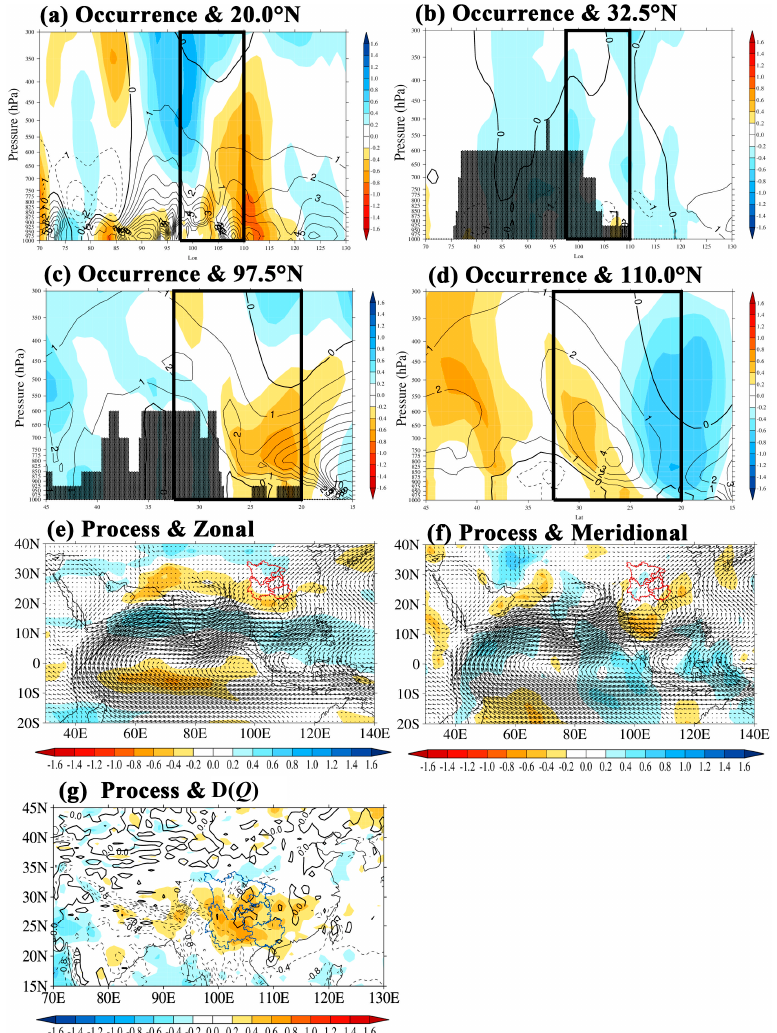
Figure 14. ( a – d ) Same as Figure 6a–d, respectively, which represent vertical cross-sections of composited meridional or zonal water vapor transport (WVT) for drought occurrences at the boundaries of Southwest China (SWC). ( e , f ) Same as Figure 5a,e, which are composites of: ( e ) zonal; and ( f ) meridional standardized anomalies (SA) of vertically integrated water vapor transport (WVT) for drought processes. ( g ) Same Figure 4b, which represents a composite of drought processes for vertically integrated water vapor flux divergence (D( Q ); contours) and its standardized anomalies (SA; shadows) in SWC. The original data source of ( a – g ) is ERA-Interim re-analysis datasets.